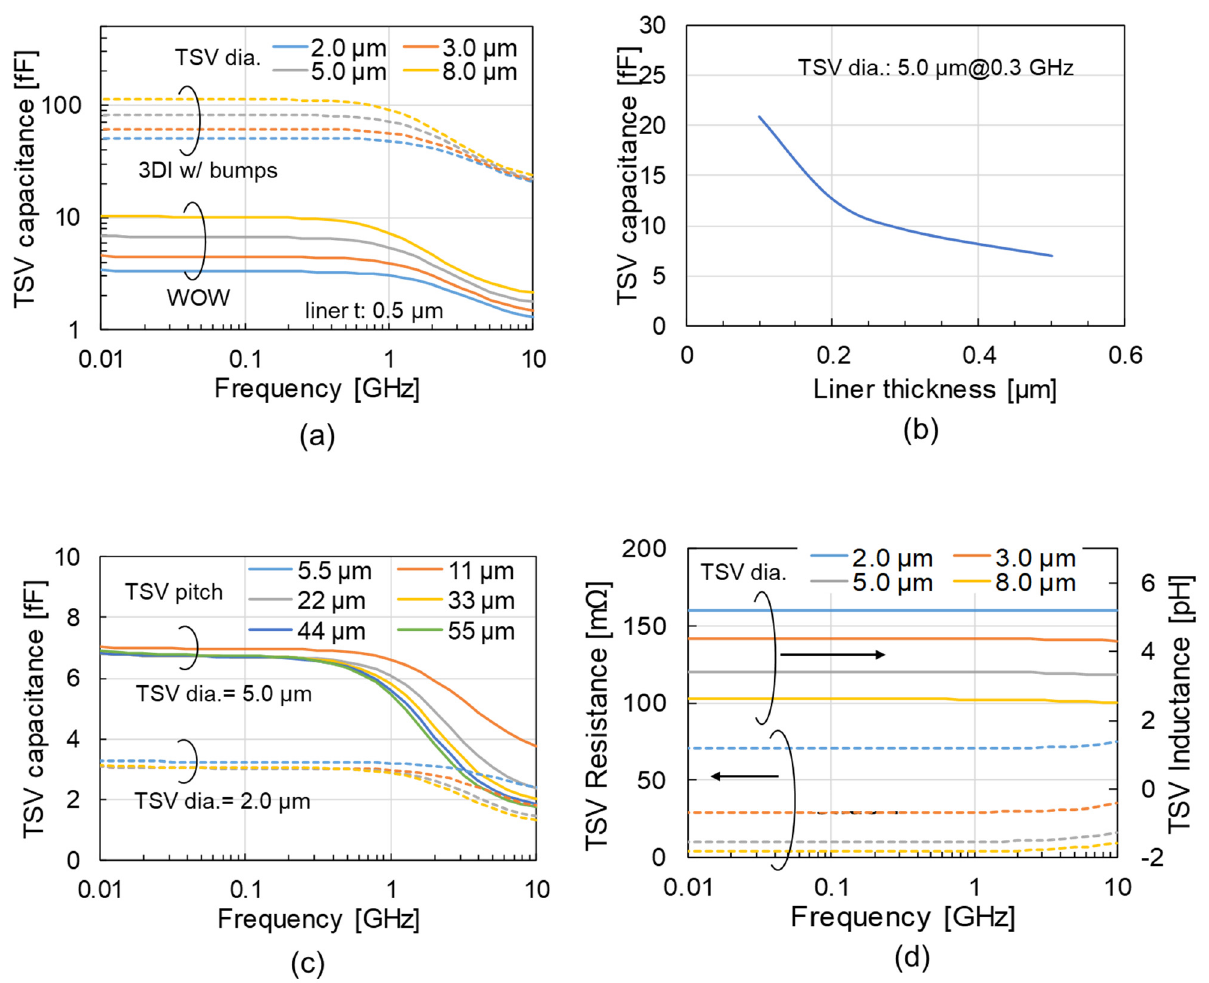
Figure 31. Calculation results of TSV capacitance: ( a ) frequency characteristics of capacitance, ( b ) impact of liner thickness, ( c ) impact of TSV pitch and ( d ) frequency characteristics of resistance and inductance.